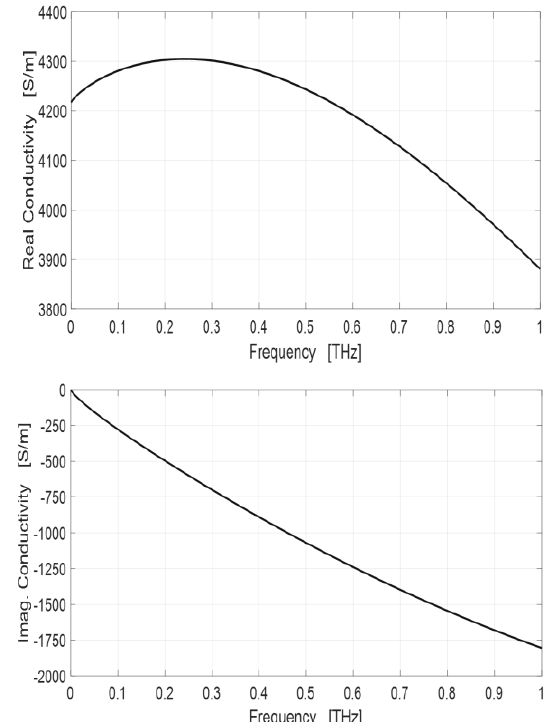
Figure 1: The variation of the complex conductivity (real part and imaginary part) as a function of the frequency for high doping concentration ( 𝑛 𝑜 = 10 18 𝑐𝑚 −3 ).